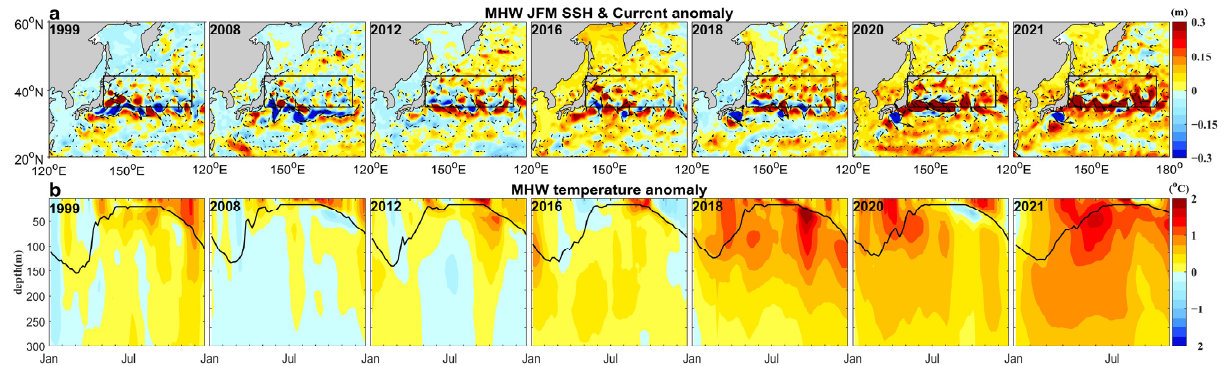
Figure 6. ( a ) Contributions from different air-sea heat flux components to the peak summer MHW temperature anomalies. ( b ) The JAS averaged TCC anomalies during the MHW years. In ( b ), the areas framed by the black dashed lines denote the KOE domain.